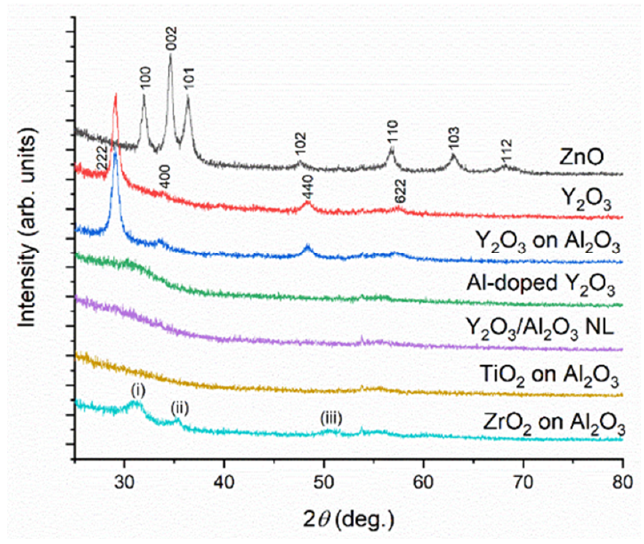
Figure 2. Grazing incidence X-ray di ff raction (GIXRD) patterns of the film materials grown on silicon.